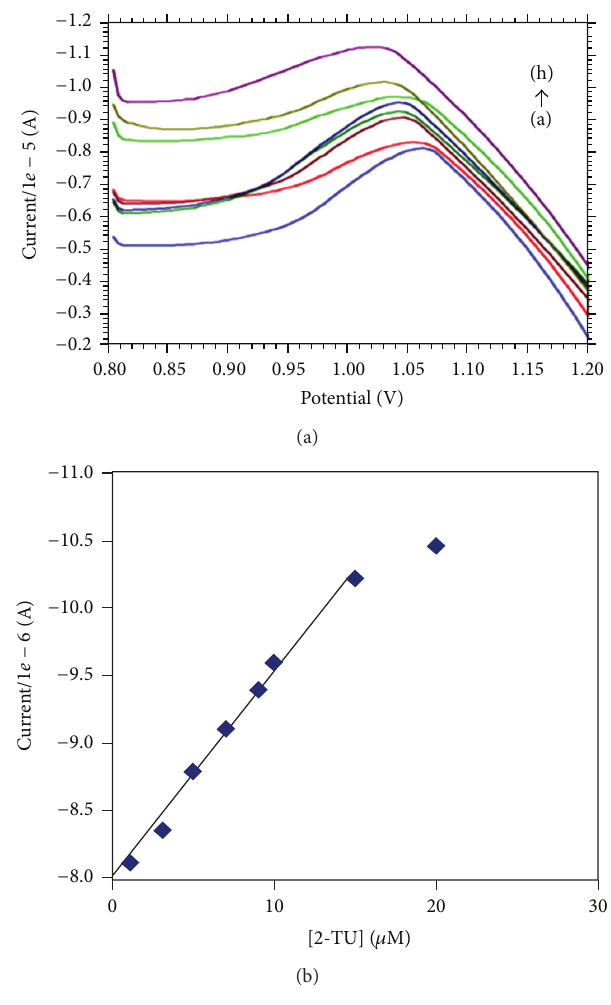
Figure 6: (a) Square wave voltammograms of GCE in 2-thiouracil solution at different concentrations at (a) 1, (b) 3, (c) 5, (d) 7, (e) 9, (f) 10, (g) 15, and (h) 20 𝜇 M and (b) plot of the peak current against concentration of 2-thiouracil. Table 2: Comparison of some methods for the determination of 2- thiouracil with the proposed method.